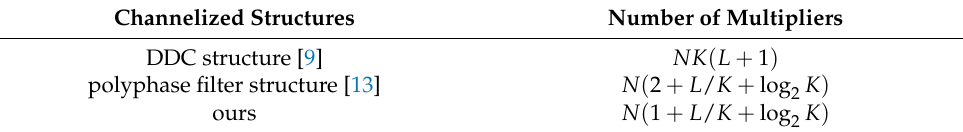
Table 5. The computational complexity of the three channelized structures. Channelized Structures Number of Multipliers DDC structure [9] NK ( L + 1 ) polyphase filter structure